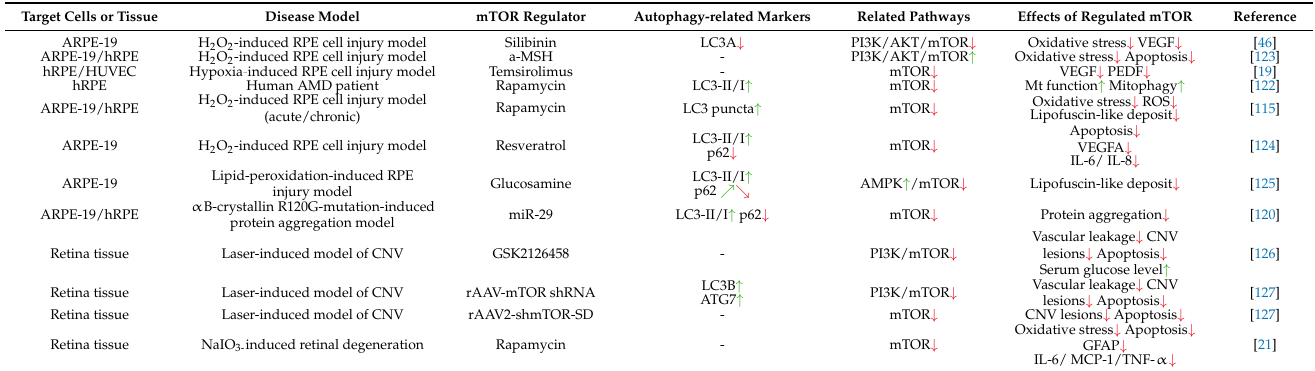
Table 3. Involvement of mTOR in AMD: in vitro and animal